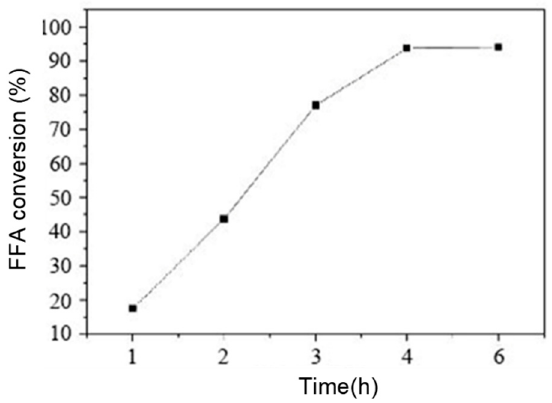
Figure 7. InfluenceofreactiontimeonthefreefattyacidconversionovertheCs 2 H 4 PV 3 MoW 8 O 40 Figure 7. Influence of reaction time on the free fatty acid conversion over the Cs 2 H 4 PV 3 MoW 8 O 40 catalyst.